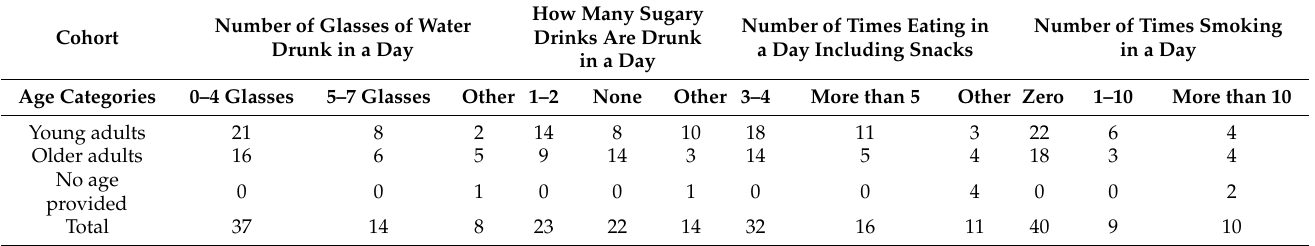
Table 1. Participants’ habits in relation to their general